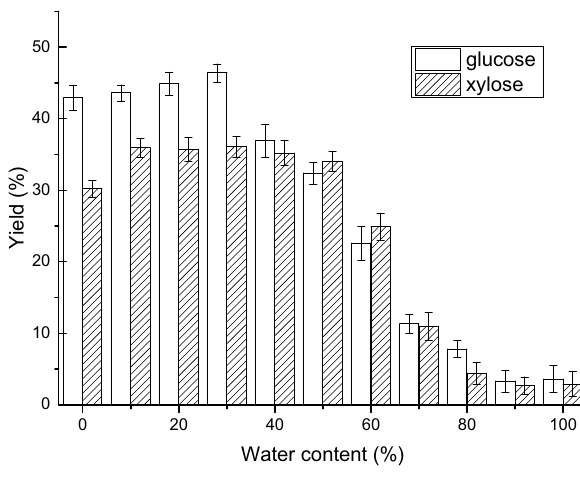
Fig. 7 Effect of water content in the water/ChCl·formic acid mix- ture (v/v) on glucose and xylose yield. (Hollow column: Glucose yield from pretreated MCC, Shadow column: xylose yield from pretreated corn stover). Reaction conditions: 0.05 g MCC or